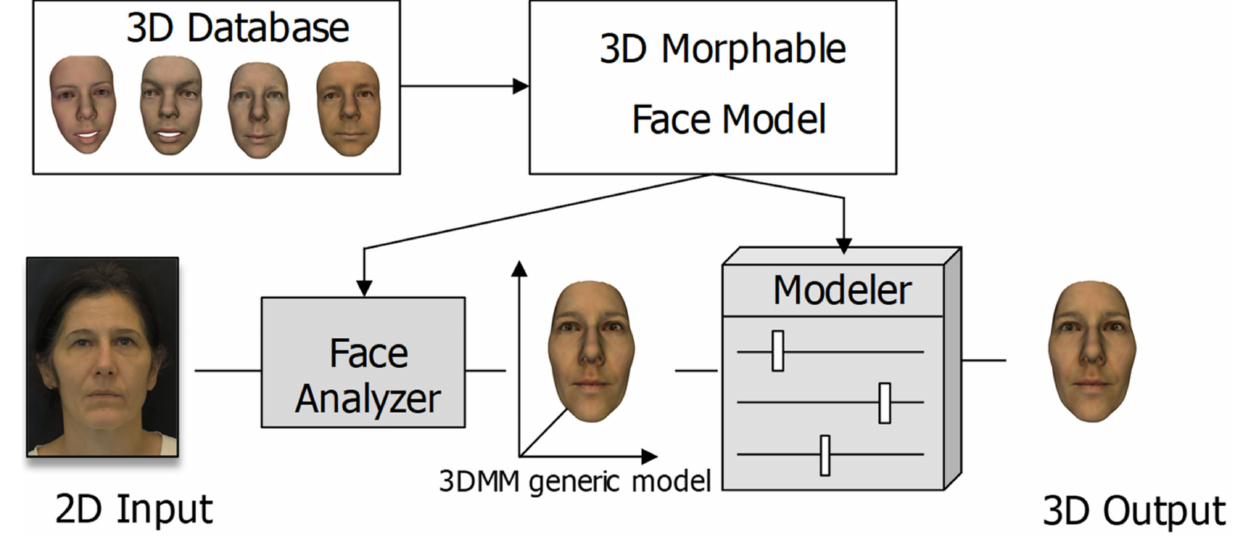
Figure 1. The general framework for reconstructing a 3D face of an individual. Two other datasets were collected in order to test more patients with facial